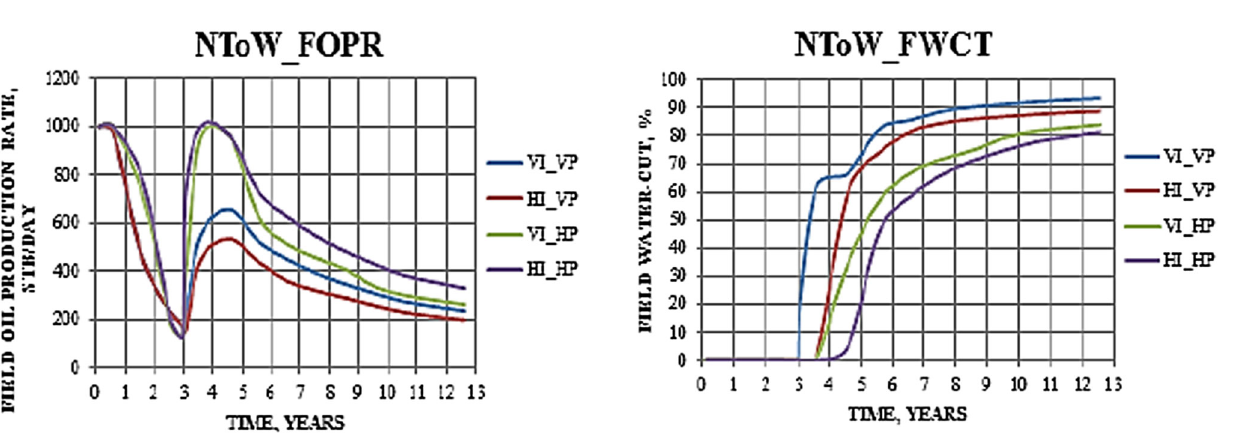
Fig. 22 Plot of the production rate of the field with time for different NToW scenarios